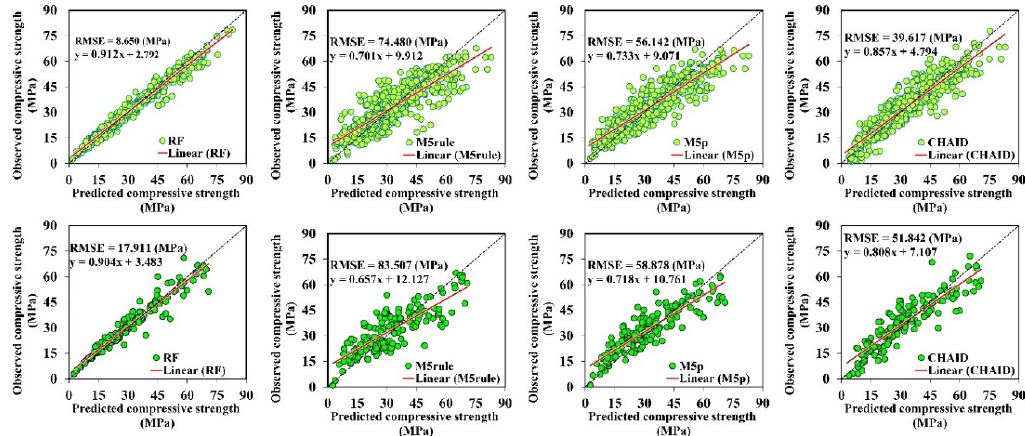
Figure 4. Scatter plots of observed and simulated CS values for training (light color) and testing (dark color) of the proposed models.